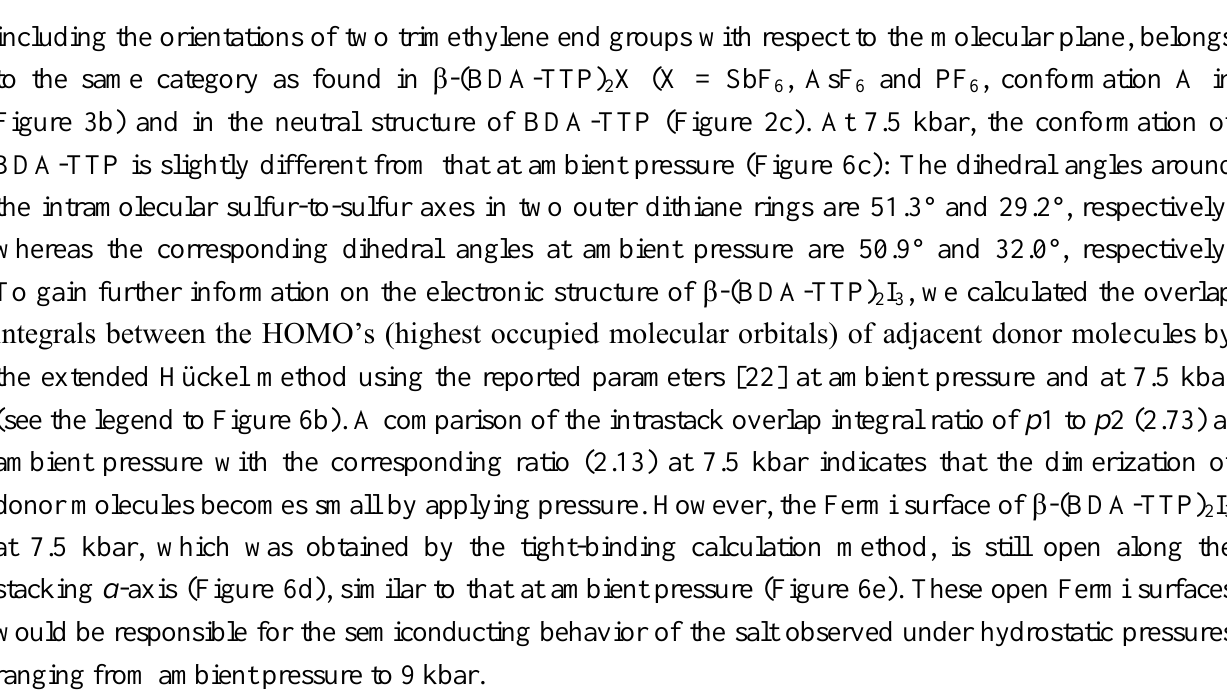
I at ambient pressure. Interplanar 2 3